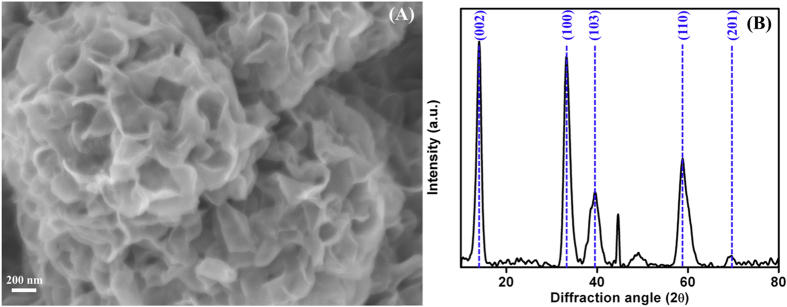
(A) High-magnification FESEM image and (B) XRD spectrum of MoS2 nanostructures.